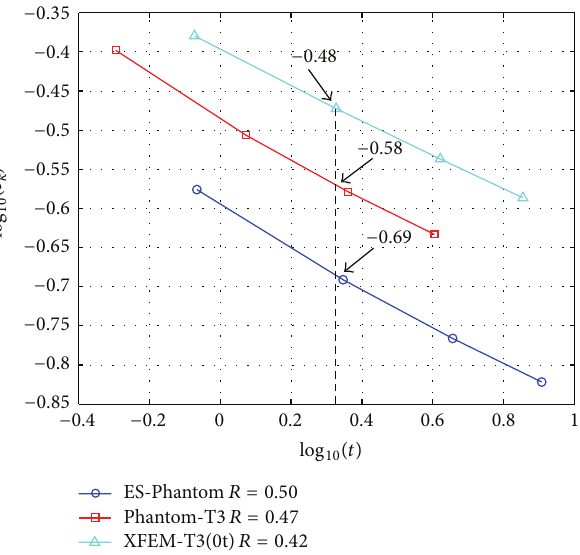
Figure 15: Computational efficiency of mode 𝐼 SIF 𝐾 𝐼 for the problem of a sheet with an edge crack under remote